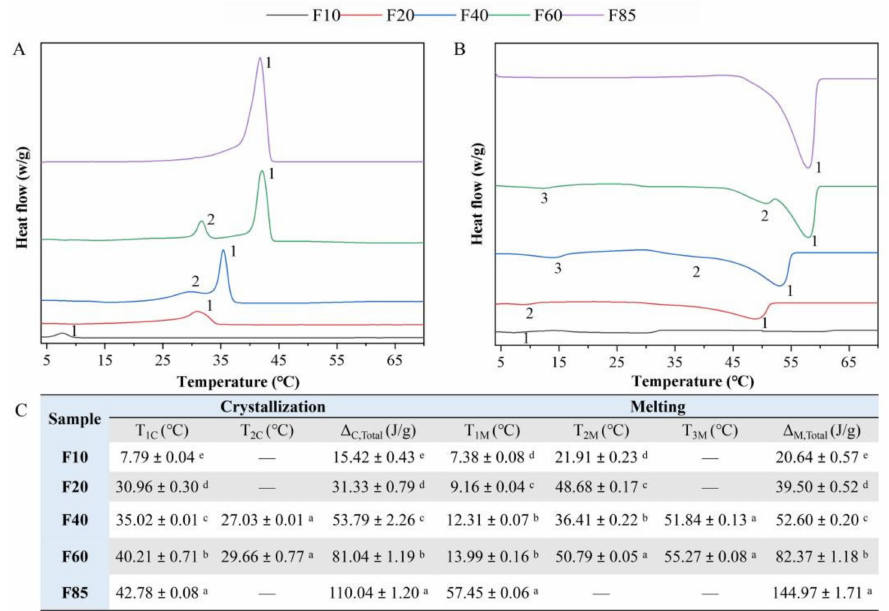
Figure 2. ( A ) Nonisothermal crystallization curves and ( B ) melting curves of blended milk fats; “1, 2, 3” indicate the first, second and third, respectively. ( C ) Nonisotermal crystallization melting temperature and total enthalpy of blended milk fats. T 1C and T 2C indicate the temperature of the first and second crystallization peaks; T 1M , T 2M and T 3M indicate the temperature of the first, second and third melting peaks, respectively; ∆ C,Total —the enthalpy of crystallization heat release; ∆ M,Total —the enthalpy of heat absorbed by melting. “—” means not detected in the sample. Results are mean ± SD ( n = 3). For each column, a–e mean that share the same letter within the same parameter were not significantly different ( p ≥